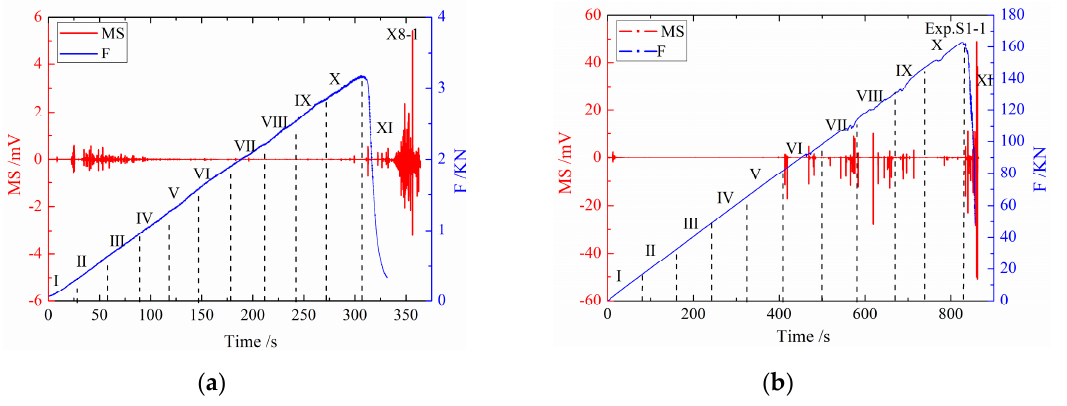
Figure 23. MS and loading force (F) of shaped coal and cement specimens. ( a ) Shaped coal and ( b ) cement.